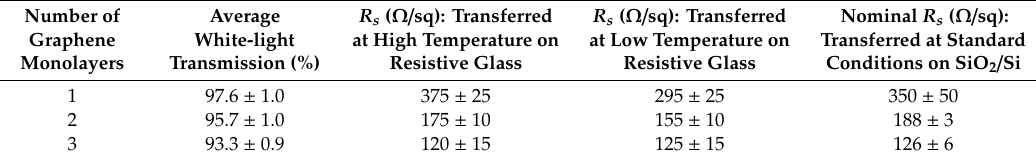
Table 2. Average white-light transmission and sheet resistance R s for graphene samples of di ff erent thicknesses transferred at high and low temperatures, respectively. The nominal R s data of graphene materials transferred on SiO 2 / Si provided by Graphenea (www.graphenea.com) are included for comparison.